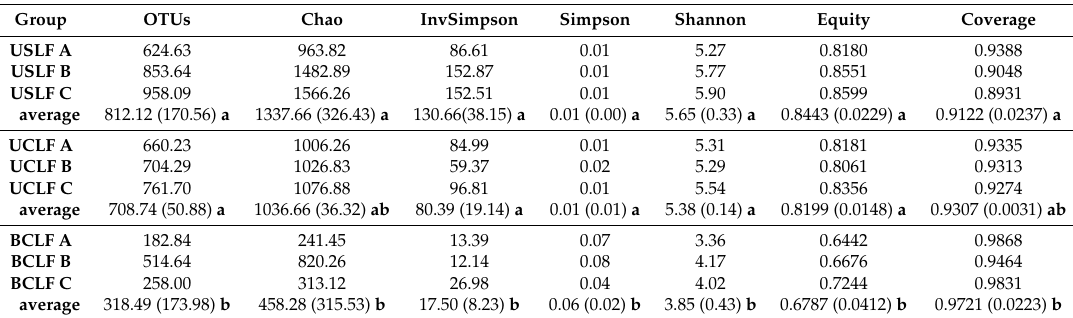
Table 2. Alpha diversity. Diversity indices for the three replicates from laurel forest soils on the unburned slope (USLF) and crest (UCLF) and the burned crest (BCLF) forests. Results correspond to normalized 4370 sequences. The average is shown with the standard deviation between brackets. Bold letters after the standard deviation indicate statistically significant di ff erences in the averages along columns according to Turkey HSD test results ( p value <